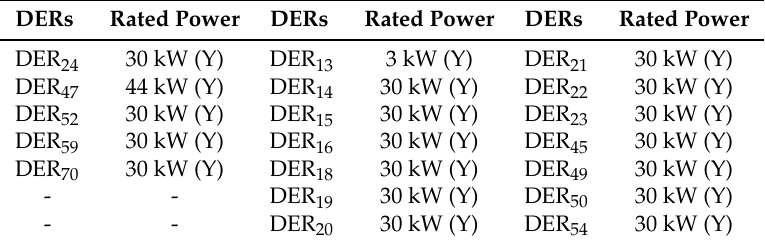
Table 1. Nominal power of distributed energy resource (DER) and storage capacity. DERs Rated Power DERs Rated Power DERs Rated